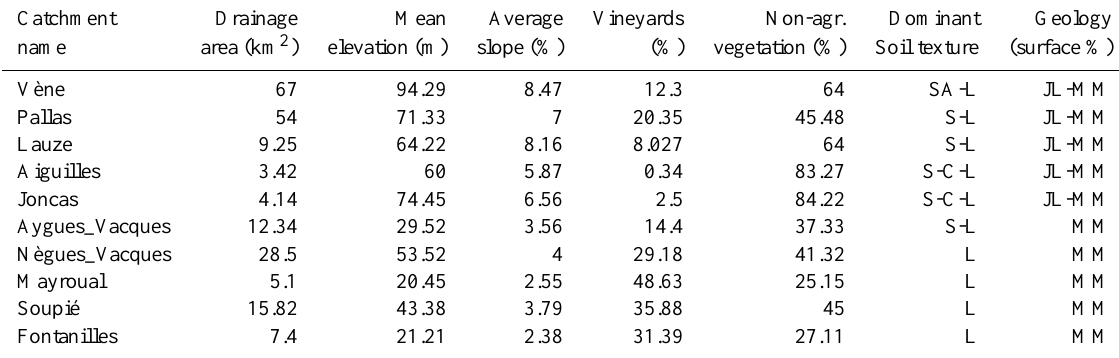
Table 2. Description of the catchments attributes. Catchment Drainage Mean